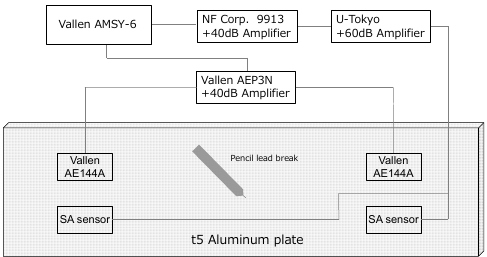
Figure 4. Block diagram of PLB test. Abbreviations and products: AMSY-6, AEP3N, and AE144A, (Yokohama, Kanagawa, Japan); U-Tokyo, The University of Tokyo; SA, Super Acoustic